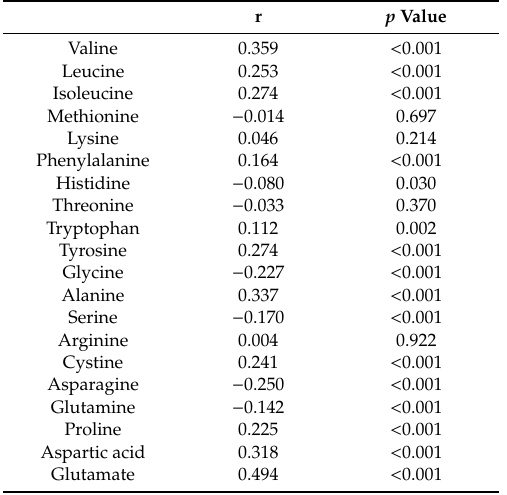
Table 3. Correlation of serum amino acid levels and HOMA-IR index.